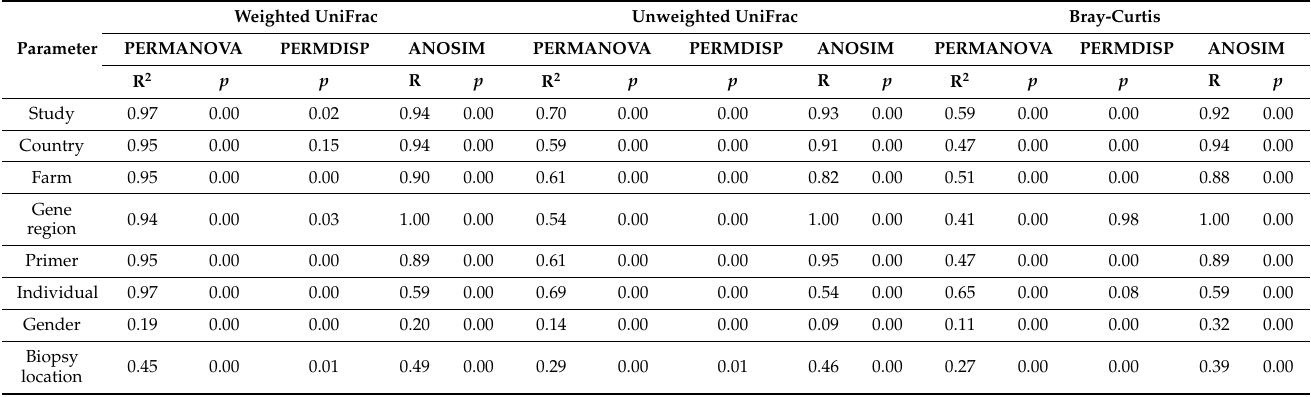
Table 3. Metadata categories affecting the epimural microbiota community structure assessed using permutational multi- variate analysis of variance (PERMANOVA), permutational analysis of multivariate dispersions (PERMDISP), and analysis of similarities